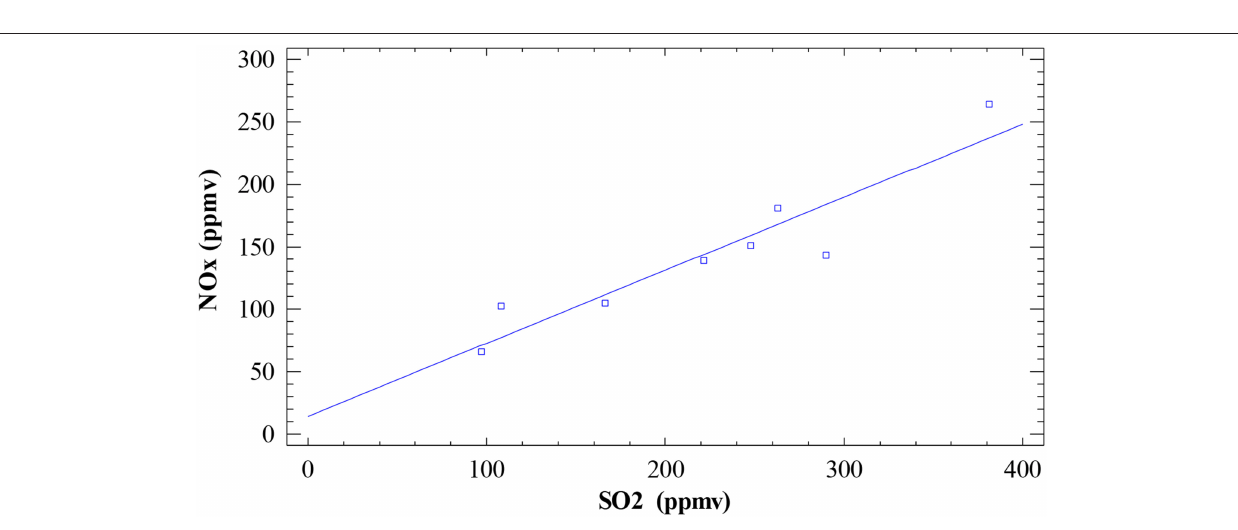
FIGURE 8 | Correlation plot between SO 2 and NOx emission for SS